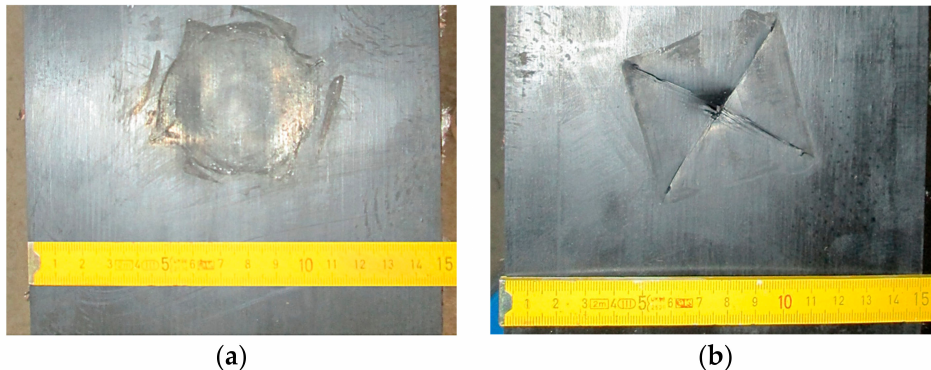
Figure 12. Damage to the upper covering layer of the examined conveyor belt due to impact stress by impactor used: ( a ) spherical (100 kg/1.4 m); and ( b ) pyramidal (100 kg/1.4 m).